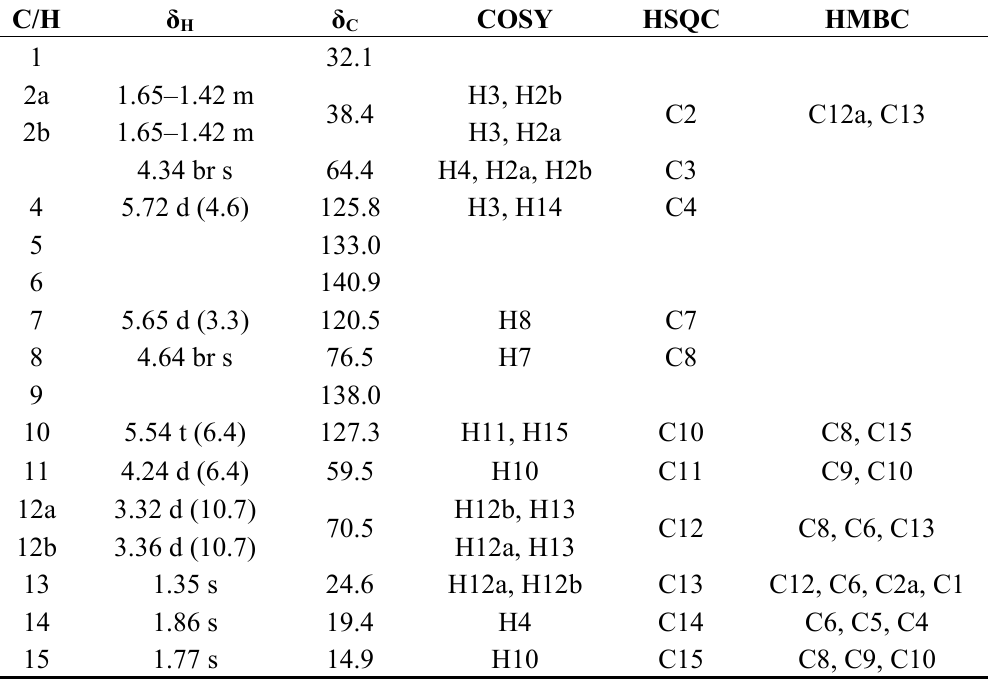
Table 1. Mono- and bi-dimensional NMR data for compound 2 .